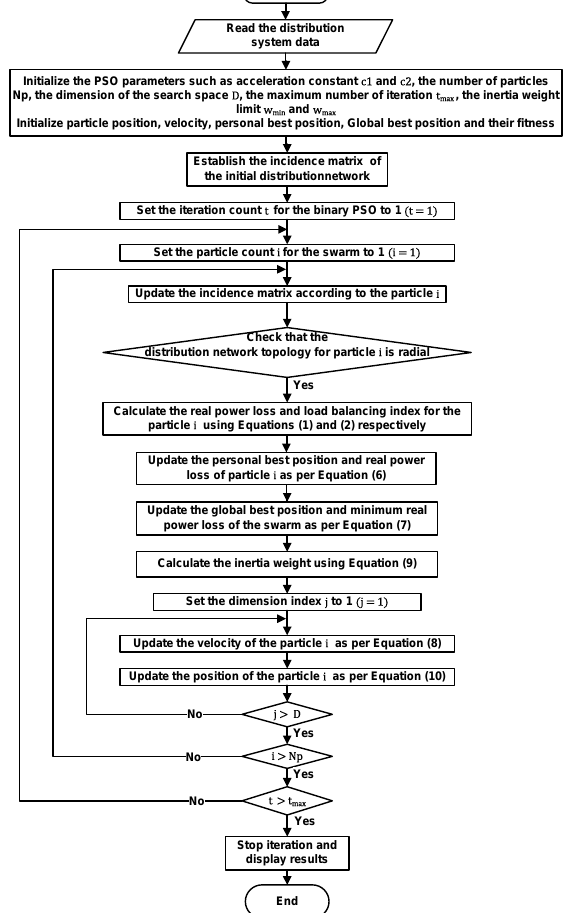
Figure 2. The developed Discrete PSO algorithm for the multi-objective distribution network feeder reconfiguration problem.